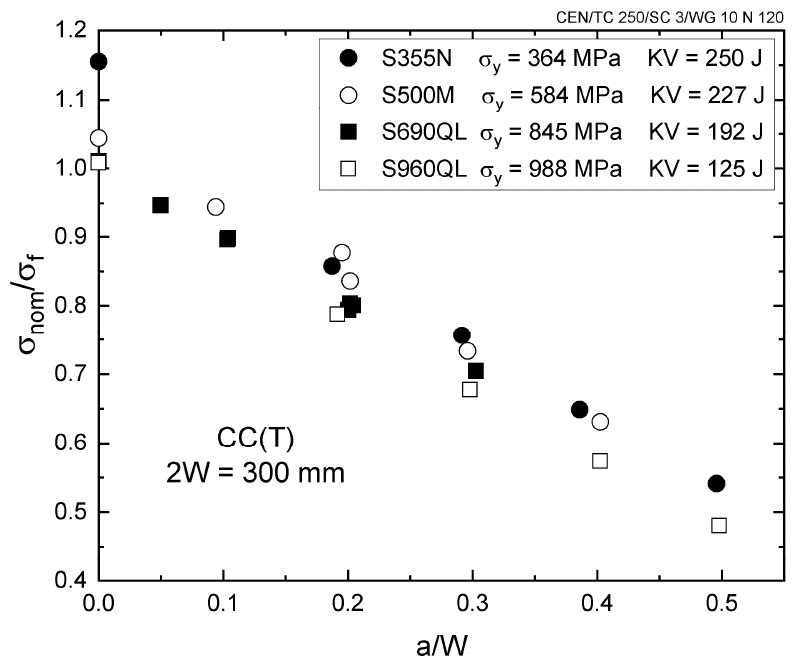
Figure 7. CC(T) test maximum load (nominal stress) values divided by flow stress for four different steels, as a function of relative crack length a/W [8].